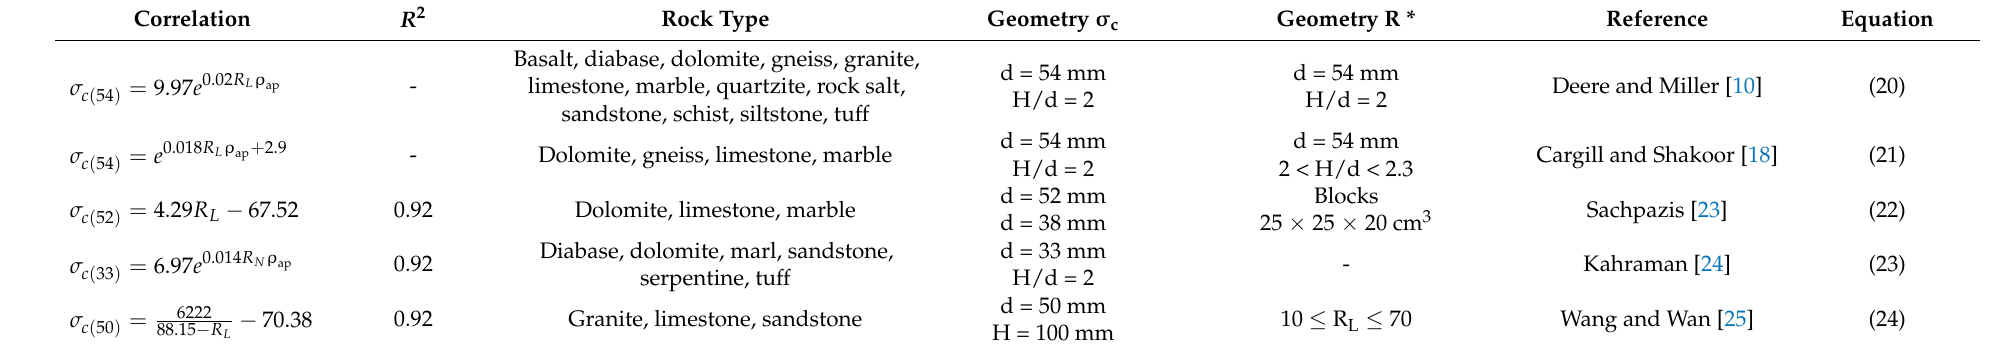
Table 2. Predictive models of simple compressive strength (MPa) from the number of rebounds of the Schmidt